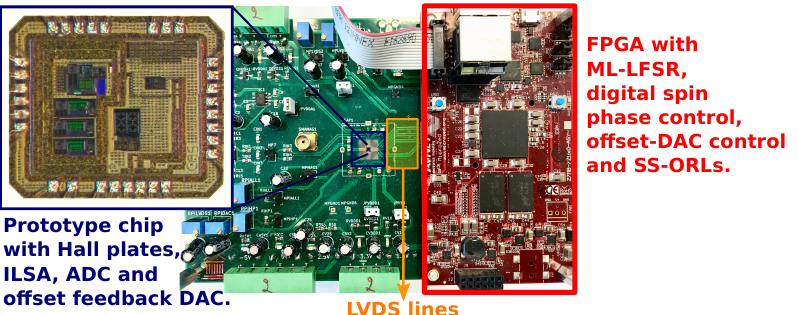
Figure 11. Photo of the test PCB containing the wire-bonded ILSA prototype chip [13] (shown zoomed-in in blue frame) and the FPGA (red board). In addition, the LVDS lines forming the communication between the chip and FPGA board are visible in the orange